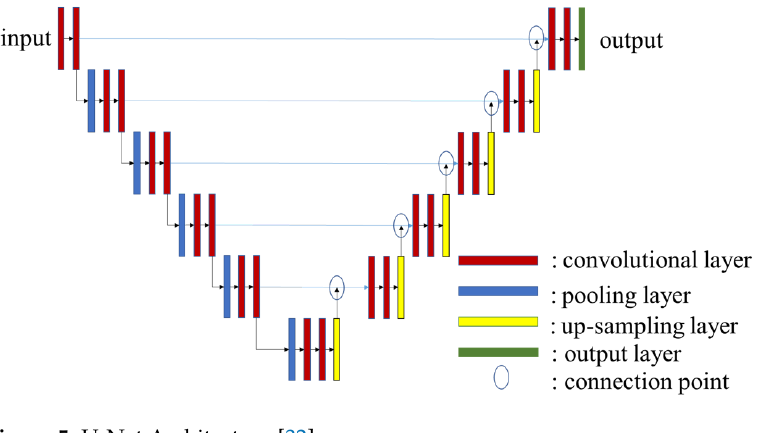
Figure 5. U-Net Architecture